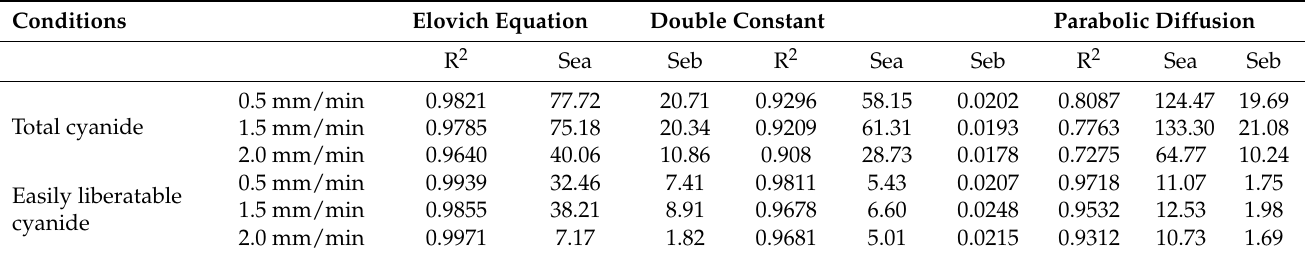
Table 4. Coefficients of determination (R2) and standard errors (Se) of three kinetics equations.